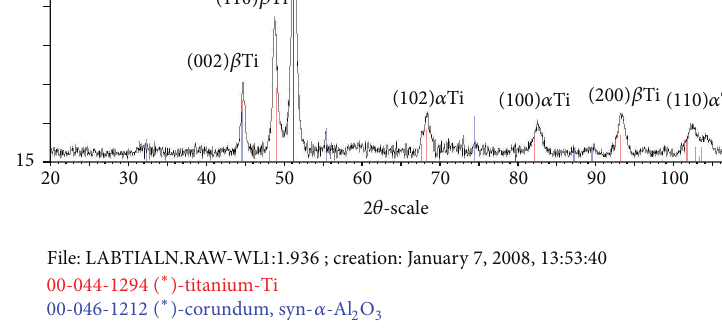
Figure 5: XRD spectrum of Ti-6Al-7Nb alloy.